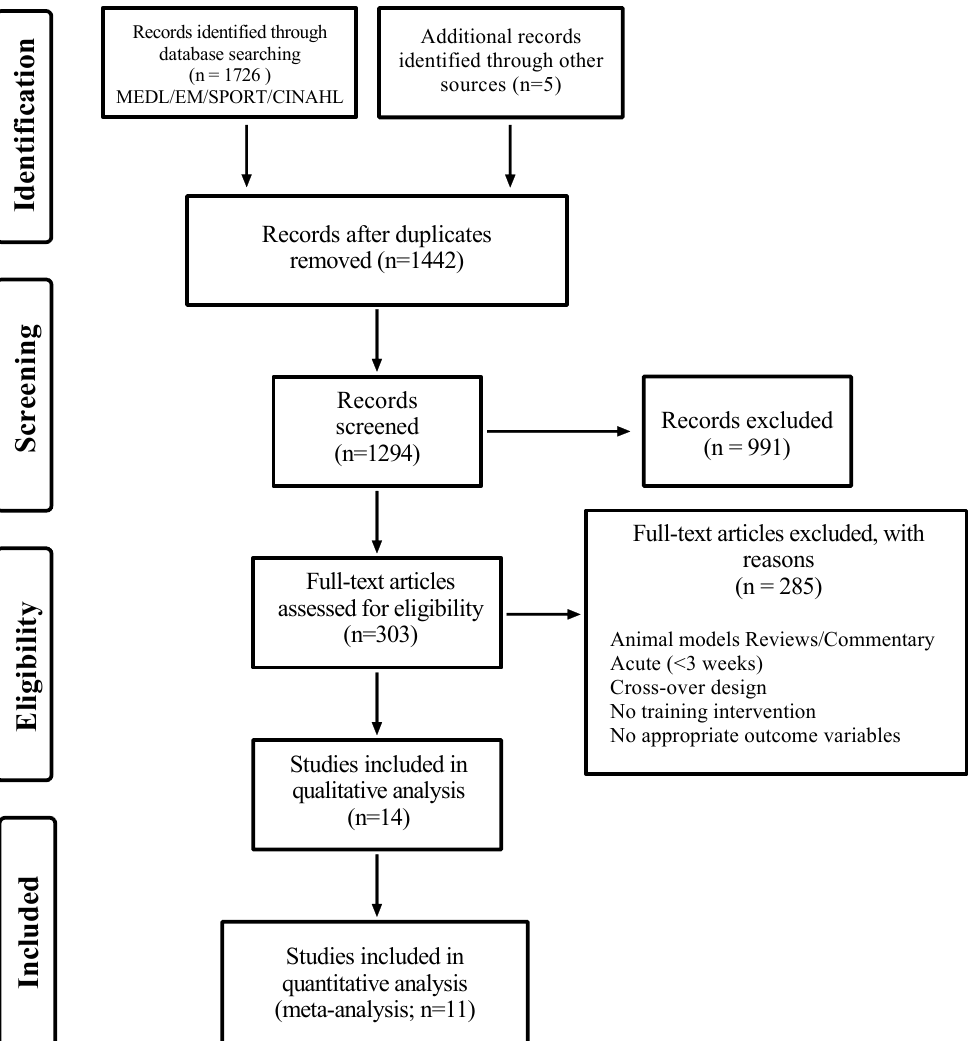
Figure 1. Preferred Reporting Items for Systematic Reviews and Meta-Analysis (PRISMA) flow chart.